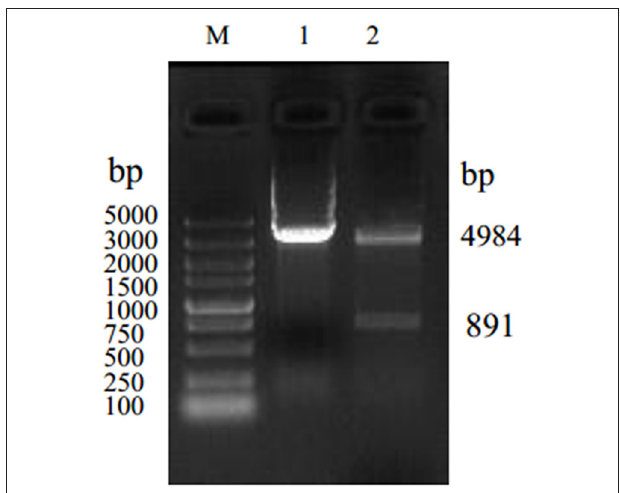
FIGURE 1 | Identification of the recombinant plasmid pGex-6p-1- Omp2 by restriction enzyme digestion with BamH I and Sal I. Lane M. DNA marker 5,000; lane 1: product of plasmid pGex-6p-1; lane 2: recombinant plasmid pGex-6p-1- Omp2